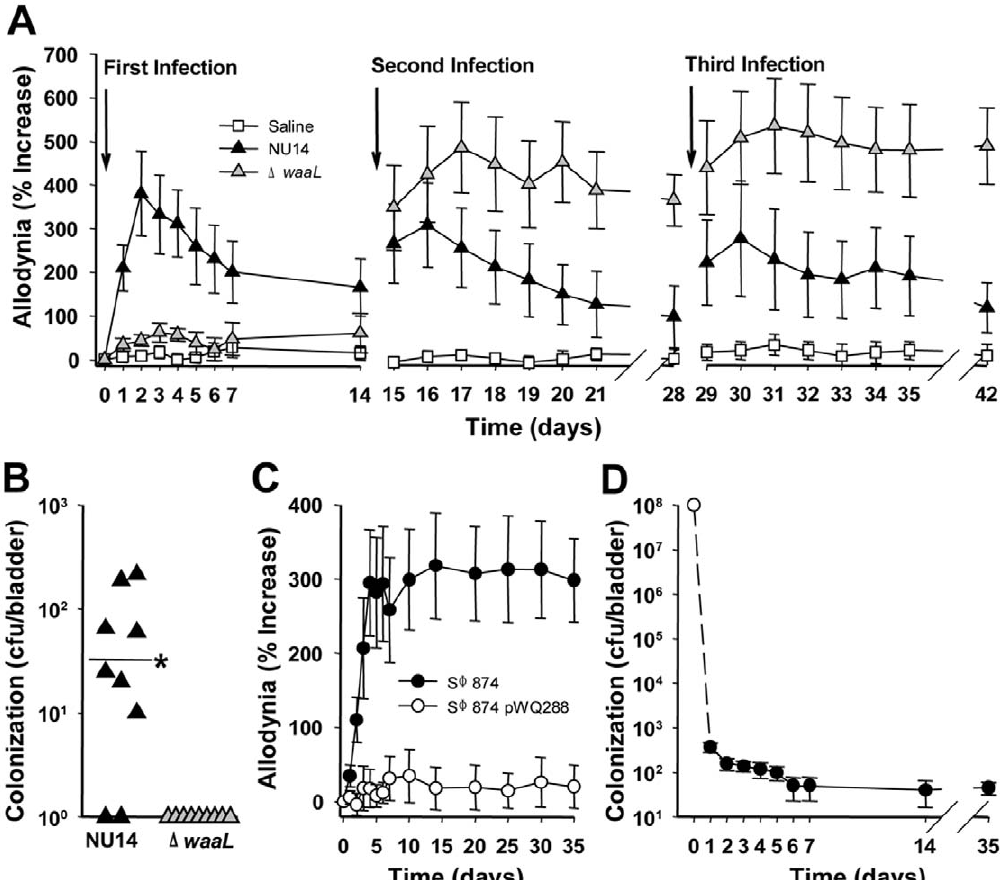
Figure 1. TLR4 mediates chronic pain. UTI was induced in female mice by instilling 10 8 E. coli into the bladder, and tactile allodynia and bladder colonization were quantified. ( A ) Mice were instilled repeatedly with saline, NU14, or D waaL (n=9). NU14 induced resolving acute pain (P , 0.001 Days 2–5, P , 0.01 Days 1 and 6, P , 0.05 Days 7–10), but D waaL induced chronic pain following the second infection. ( B ) Bladders from mice in (A) had detectable NU14 colonization but not D waaL colonization (P , 0.044). ( C ) S W 874 pain (n=10) was abrogated in mice infected with S W 874 pWQ288 (n=10). ( D ) S W 874 is cleared rapidly from the bladder; open circle indicates inoculum (n=5 Days 1–14, n=10 Day 35).